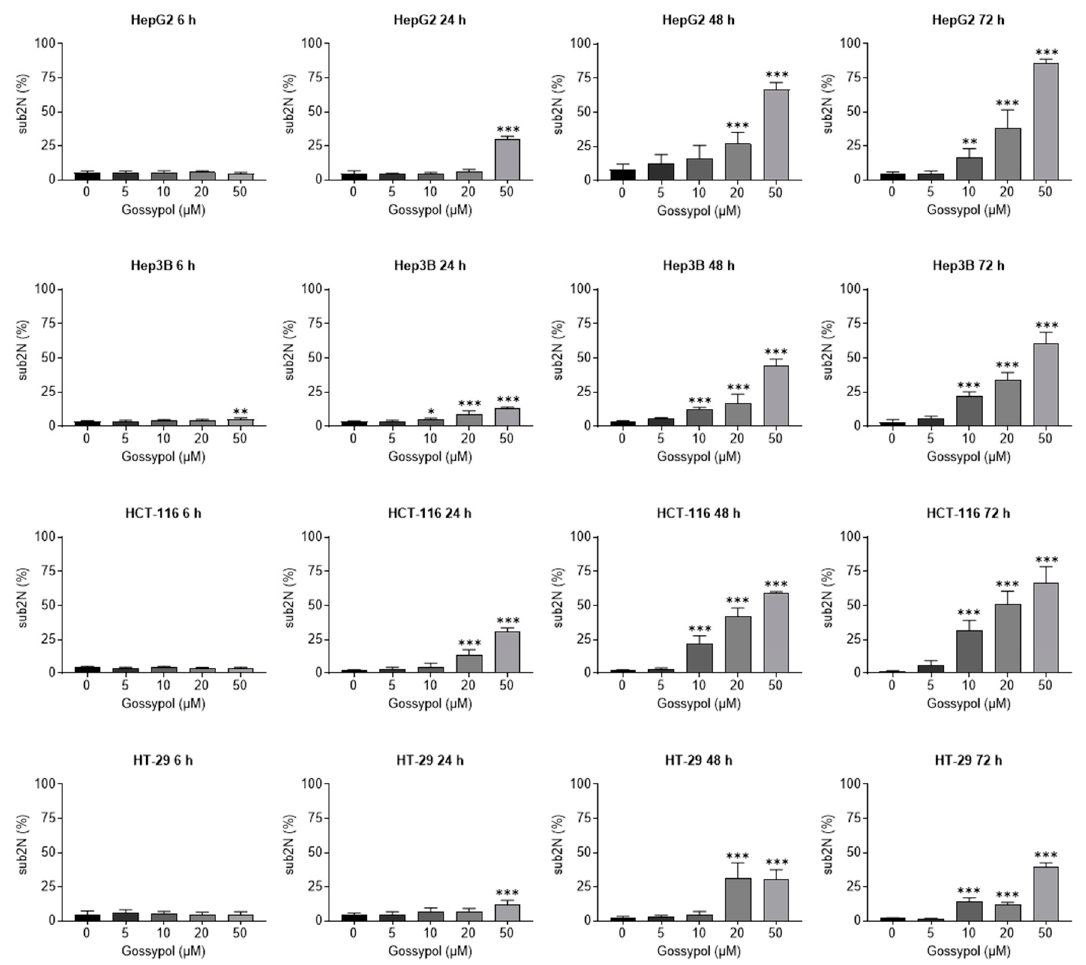
Figure 2. Gossypol induces apoptosis. A concentration-dependent (5 µM, 10 µM, 20 µM, 50 µM) increase in apoptotic cells by gossypol treatment was analyzed for hepatic and colon carcinoma cells (hepatoma: HepG2, Hep3B; colon carcinoma: HCT-116, HT-29). Detection of the apoptotic sub2N fraction was performed by flow cytometric analysis of PI-stained cells obtained after 6 h, 24 h, 48 h, and 72 h incubation with gossypol. Error bars represent mean ± SD of three independent experiments, each performed in triplicate. For statistical analysis, one-way ANOVA Dunnett’s multiple comparison test was applied. Confidence interval 95%; *: p ≤ 0.05; **: p ≤ 0.01; ***: p ≤ 0.001. PI, propidium iodide.